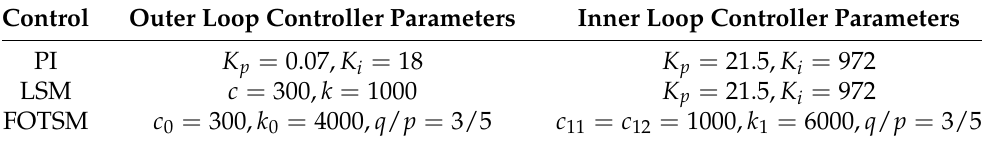
Table 2. Controller design